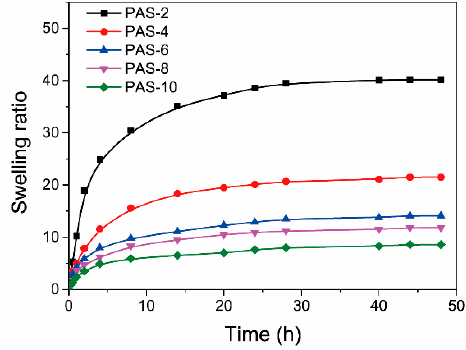
Figure 5. Time-dependent swelling ratios of PAS gels.